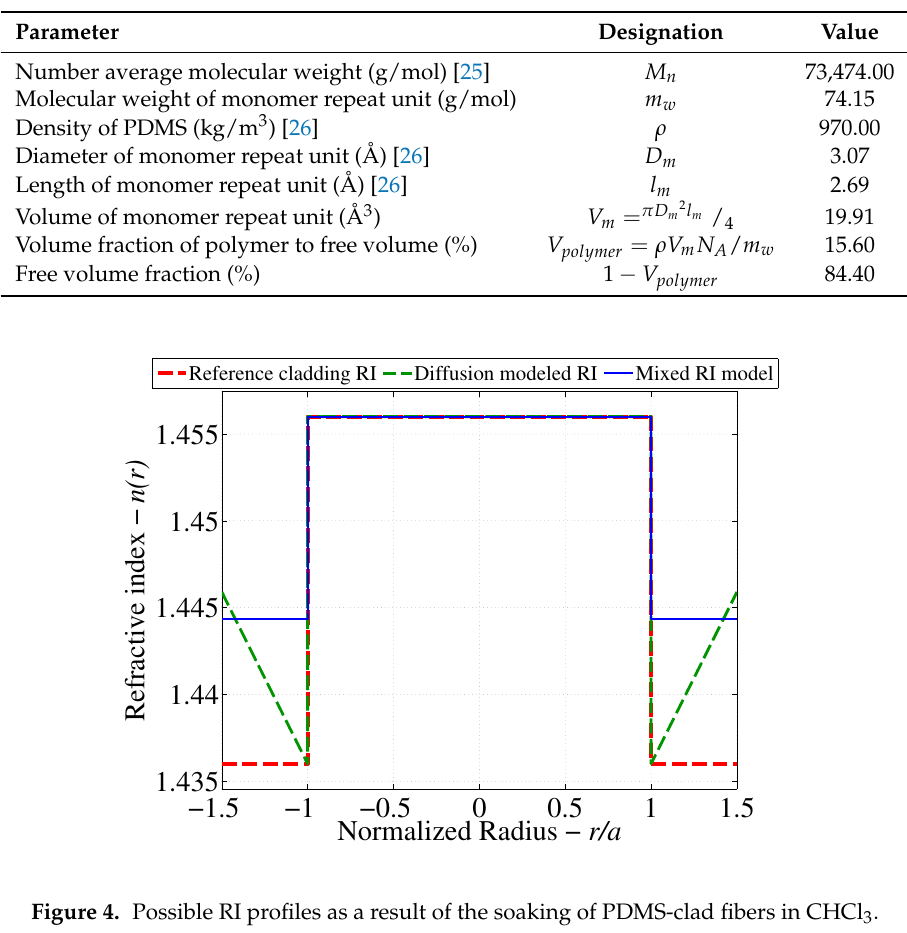
Figure 4. Possible RI profiles as a result of the soaking of PDMS-clad fibers in CHCl 3